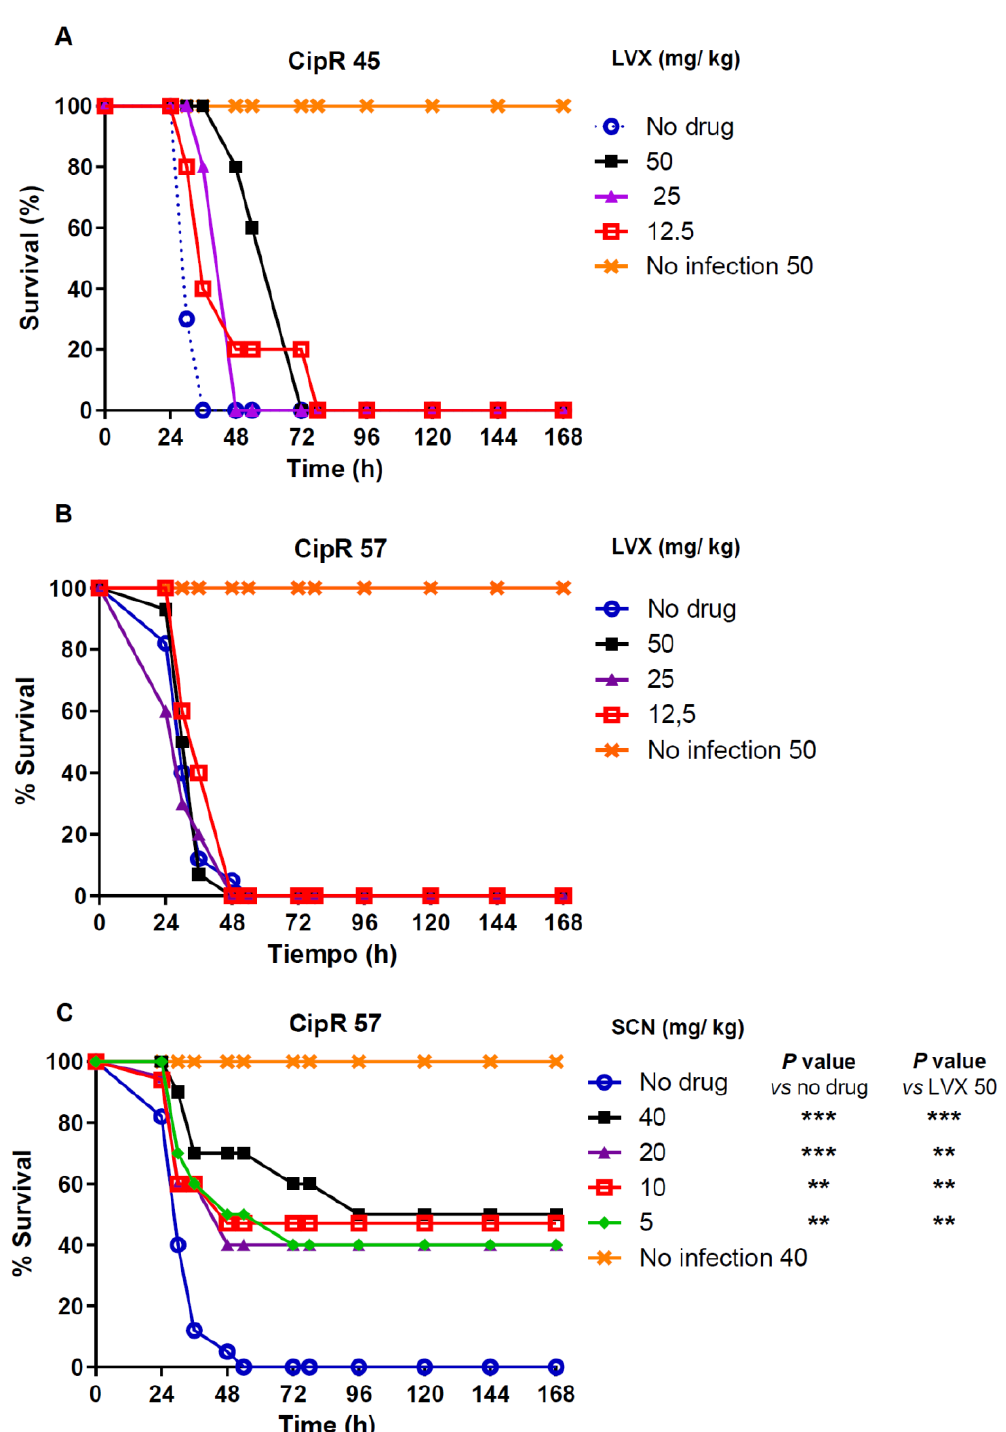
Figure 1. Percentage survival of groups of 5 mice intraperitonealy infected with two times the MLD (1 × 10 2 CFU/mouse) of isolate CipR45 ( A ) or CipR57 ( B , C ). Experiments were followed over a 7-day period. Antibiotic treatment or placebo was administered subcutaneously every 12 h during the first 48 h. The doses of each antibiotic administered are indicated for LVX (A and B) or SCN (C). Data are the average of 2 (for SCN 40 mg/kg) to 4 independent replicates. The long rank test was used for survival curve comparison between the no drug group and the groups treated with the indicated SCN concentrations. p values are: ** p < 0.01; *** p <